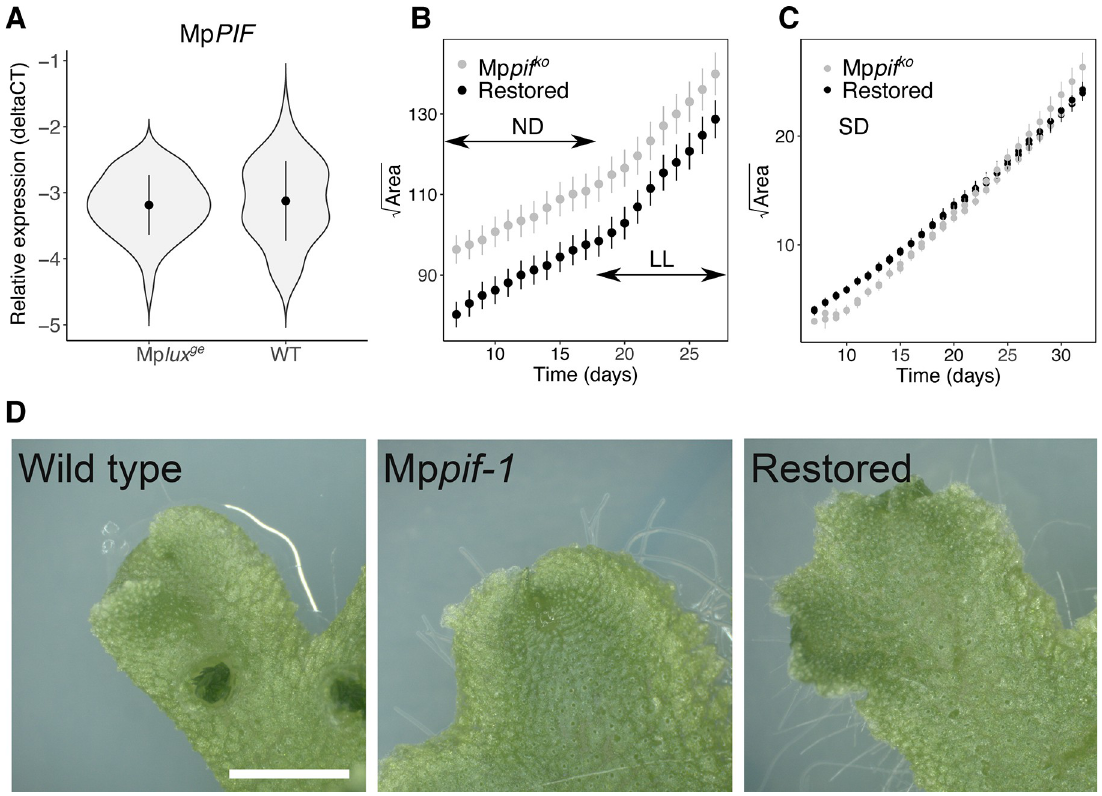
Fig 4. Altered growth of Marchantia polymorpha lux ge knock-out mutants is not mediated through Mp PIF . (A) Graph shows the average expression of Mp PIF in wild type (Upp1 and Upp5) and Mp lux ge mutants 9 and 19 , measured by qRT-PCR. (B) Square root of area plotted over time for Mp pif ko -1 and restored line Mp pif ko / Mp PIF pro :Mp PIF-1 . Each point is an average ± SD of 11 and 18 gemma for Mp pif and restored line, respectively. Statistical analysis revealed no difference in slope ( P > 0.8). ND, neutral days. LL, continuous light. (C) Square root of area plotted over time for Mp pif ko -1 , Mp pif ko -2 and restored lines Mp pif ko / Mp PIF pro :Mp PIF-1 , Mp pif ko / Mp PIF pro : Mp PIF-2 . Statistical analysis gave a P < 10 − 15 for equal slopes. SD, short days. Each point is an average ± SD of 12, 12, 11, 7 gemma for Mp pif and restored lines, respectively. (D) Apical regions of adult wild type (Tak-1), Mp pif ko -1 and restored line Mp pif ko / Mp PIF pro : Mp PIF-2 . Bar 0.5 cm.